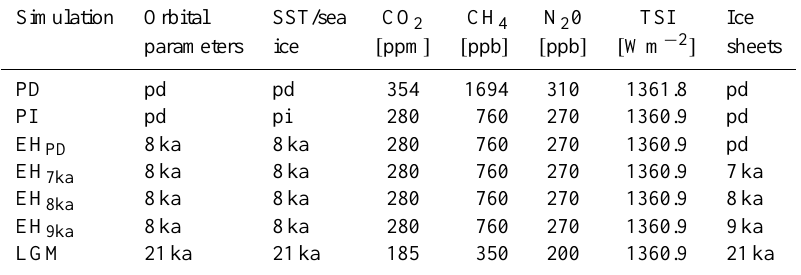
Simulation Orbital SST/sea CO 2 CH